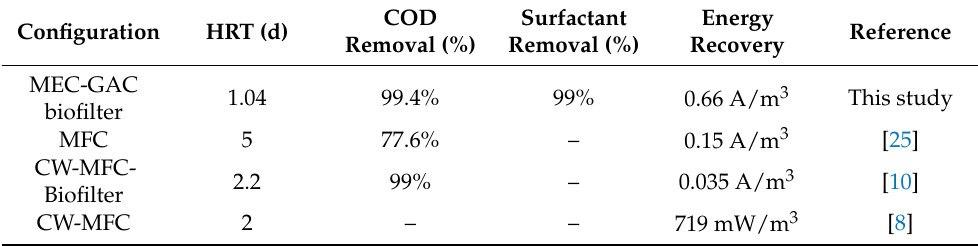
Table 1. Comparison of greywater treatment in hybrid microbial electrochemical systems.